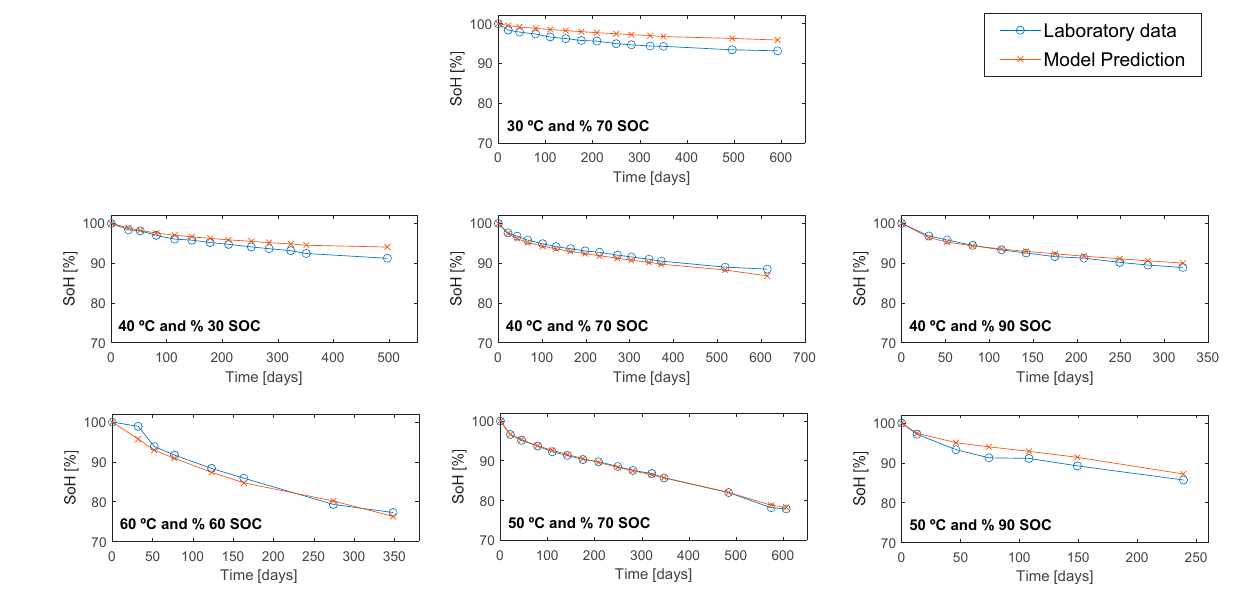
Figure 7. LFP laboratory data and TL model ageing prediction.